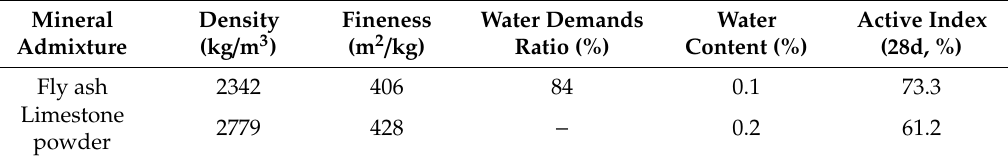
Table 3. Physical and mechanical performances of fly ash and limestone powder.